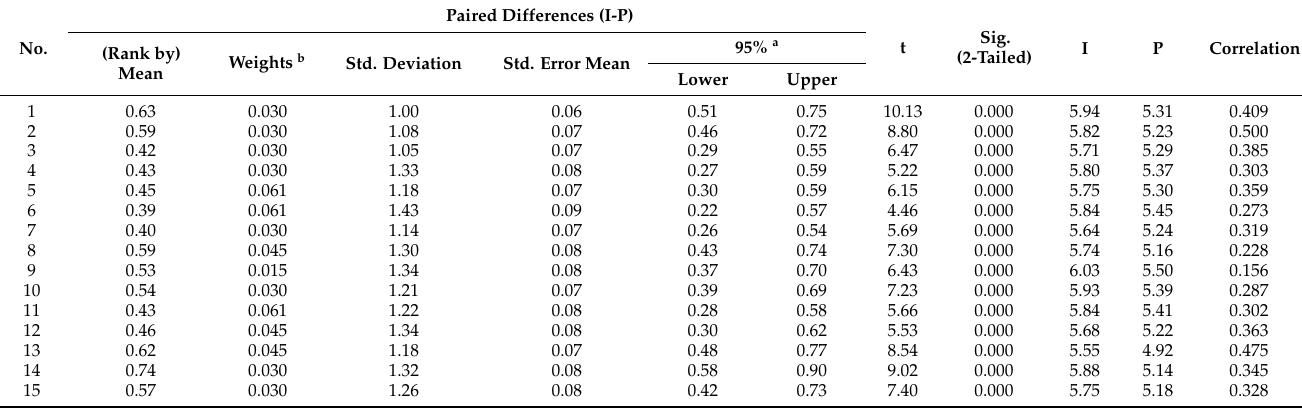
Table 5. Rank, means of importance, and performance and paired sample t -test (df =